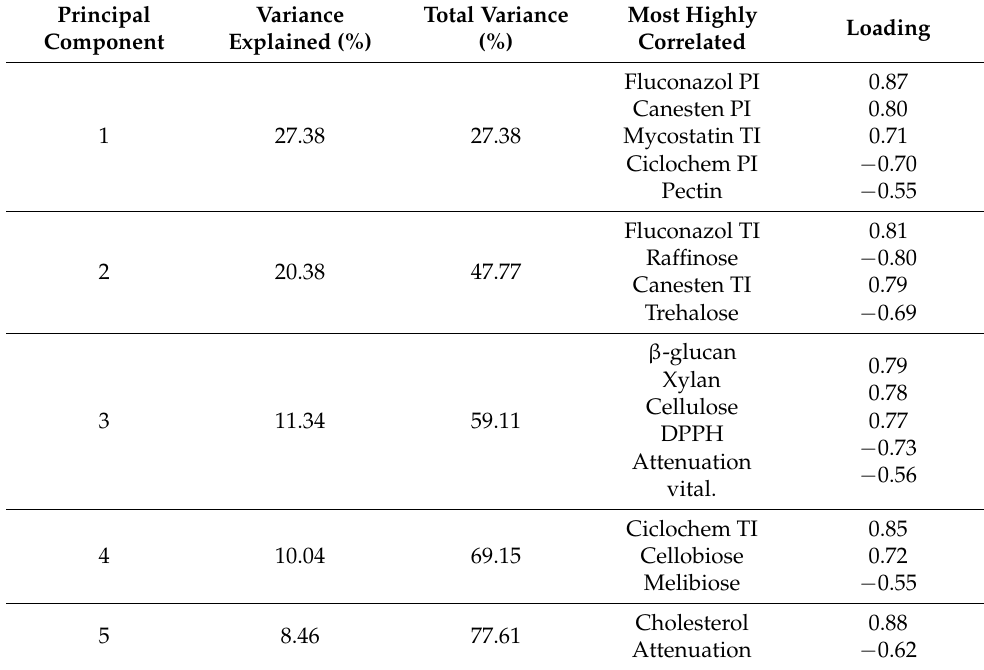
Table 5. Contributions of the highly correlated variables and their loadings in principal components 1, 2, 3, 4, and